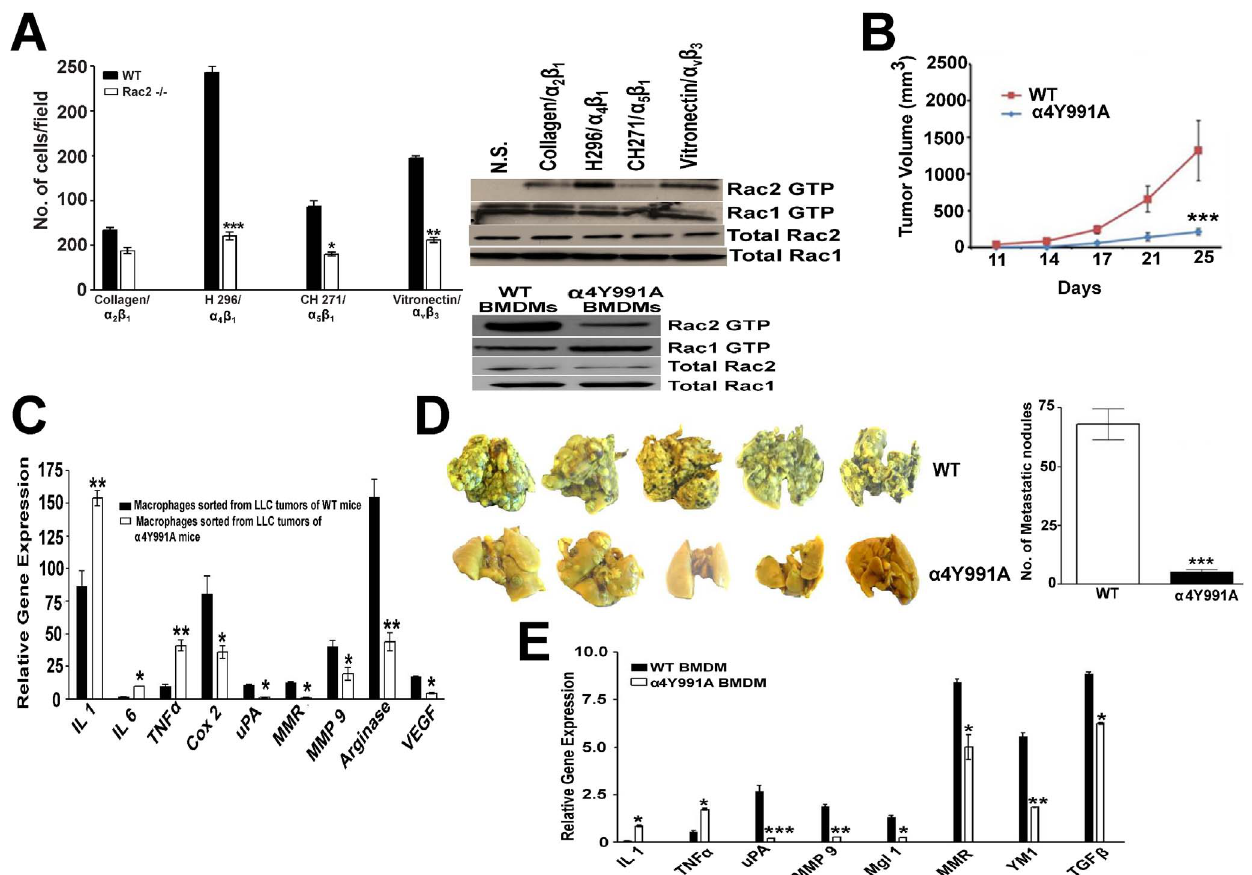
Figure 3. Rac2 signaling is required for specific a 4 b 1 integrin signaling. (A) Left panel shows BMDMs from WT, and Rac2-/- mice were tested in haptotaxis assay for capacity to migrate on different matrix proteins or fragments of fibronectin, vitronectin (via a v b 3 / a v b 5 ); H296, via a 4 b 1 ;